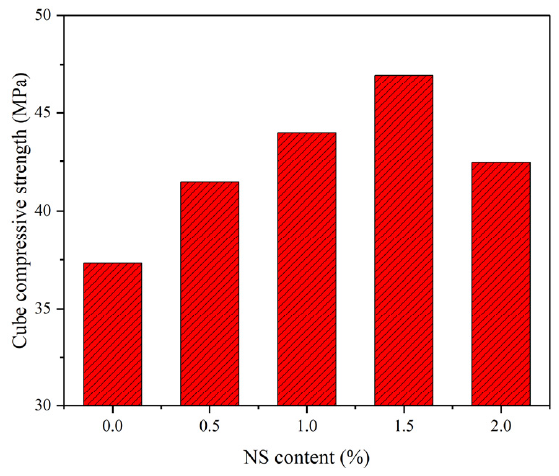
Figure 5. The cube compressive strength of NS–GPC.